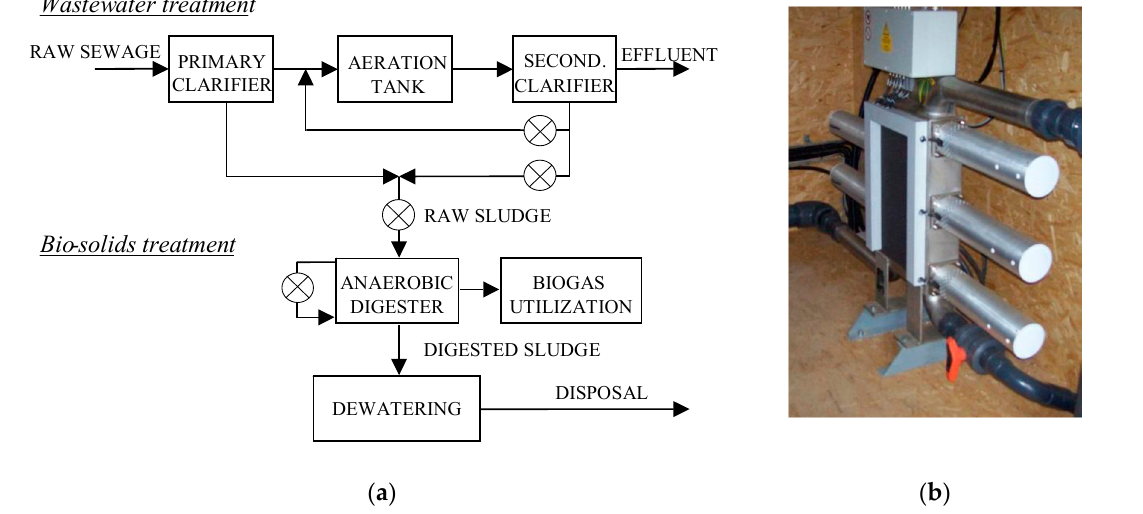
Figure 2. ( a ) Typical layout of an activated sludge process. ( ⊗ : options for bio-mass disintegration.) ( b ) Ultrasound system for improvement of biogas production on a farmland biogas plant in Löhndorf, Germany.